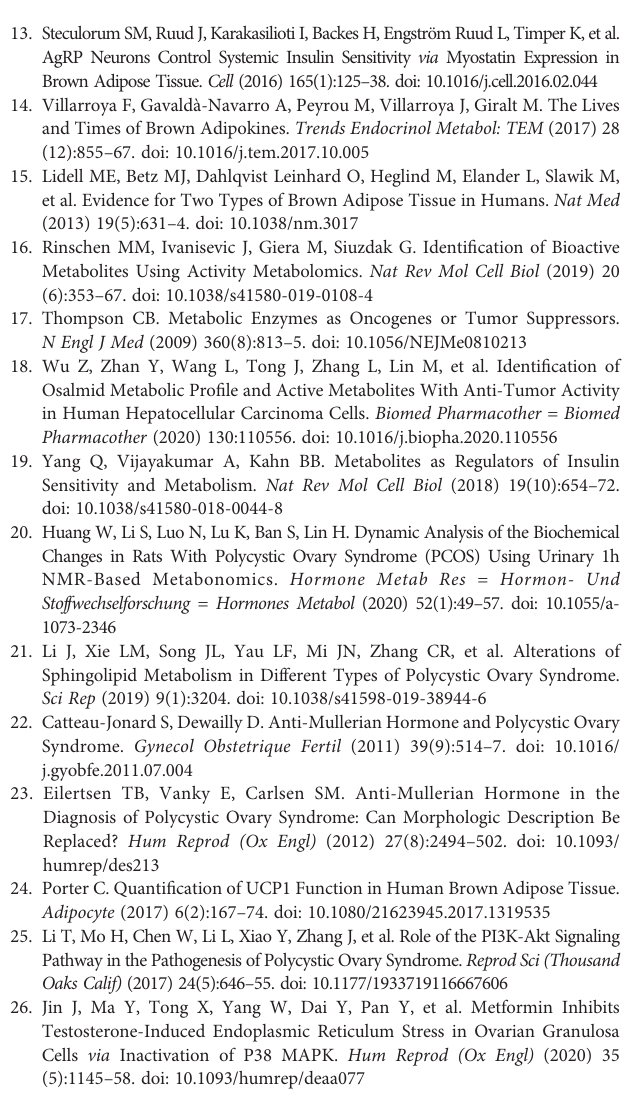
Supplementary Figure 1 | PCA scores plot showed a distinct metabolome pro fi le of DHEA+ Sham group compared with DHEA+BAT group in the positive mode and the negative mode. X-axis and Y-axis represented the fi rst and second principal components, respectively. QC, quality control; PCA, principal component